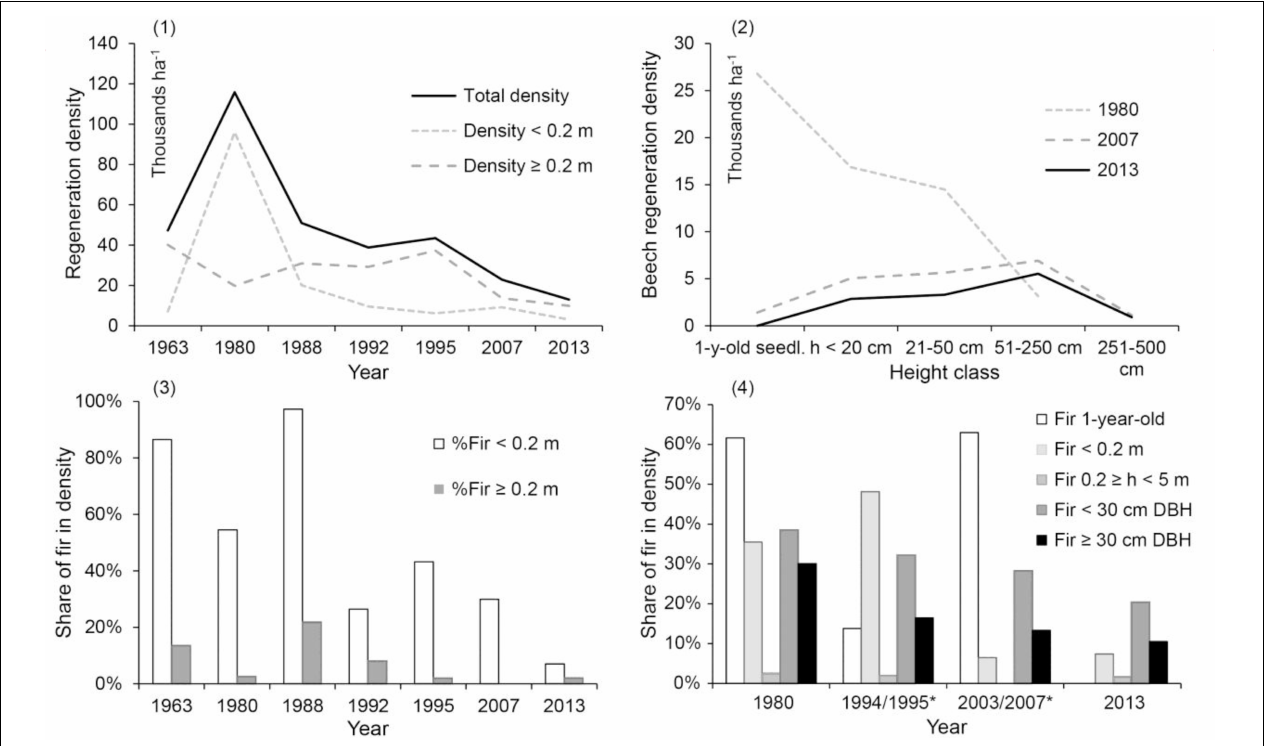
FIGURE 3 | (1) Trends in total regeneration densities by year. (2) Changes in beech regeneration density per height class between years. (3) Trends in the proportion of silver fir per height class. (4) Comparison of the proportion of silver fir in the total tree density in three developmental stages of regeneration and in two extended DBH classes. *For the 1994 and 2003 columns, regeneration data originates from 1995 and 2007, respectively. Graphs (1) and (3) include 1-year-old seedlings within the small seedling category (h < 0.2